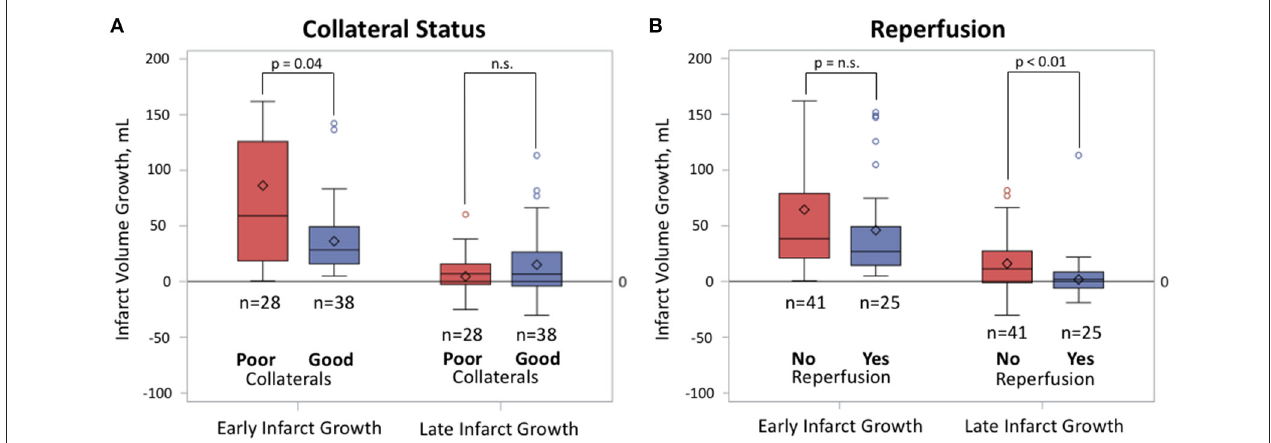
FIGURE 1 | Box plot of early and late infarct growth by collateral status and reperfusion status. Black bars represent medians. Diamonds represent means. Circles represent outliers. (A) Good collaterals show a reduction in early infarct growth only. (B) Reperfusion shows a reduction in late infarct growth